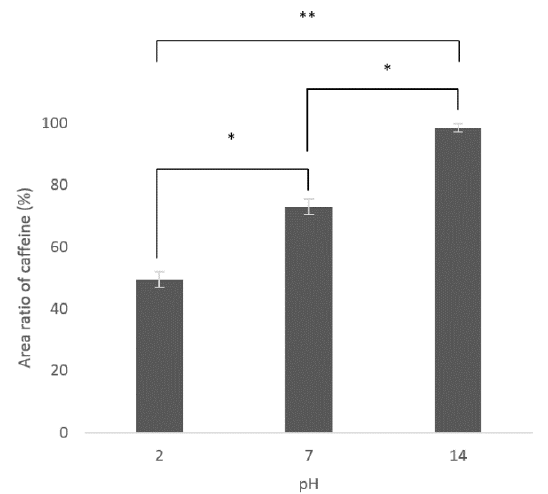
Figure 12. Chromatograms of caffeine and impurities transferred in ethyl acetate at pH = 2 (red, behind), pH = 7 (green, middle) and pH = 14 (blue, forward) during liquid/liquid extraction at room temperature.